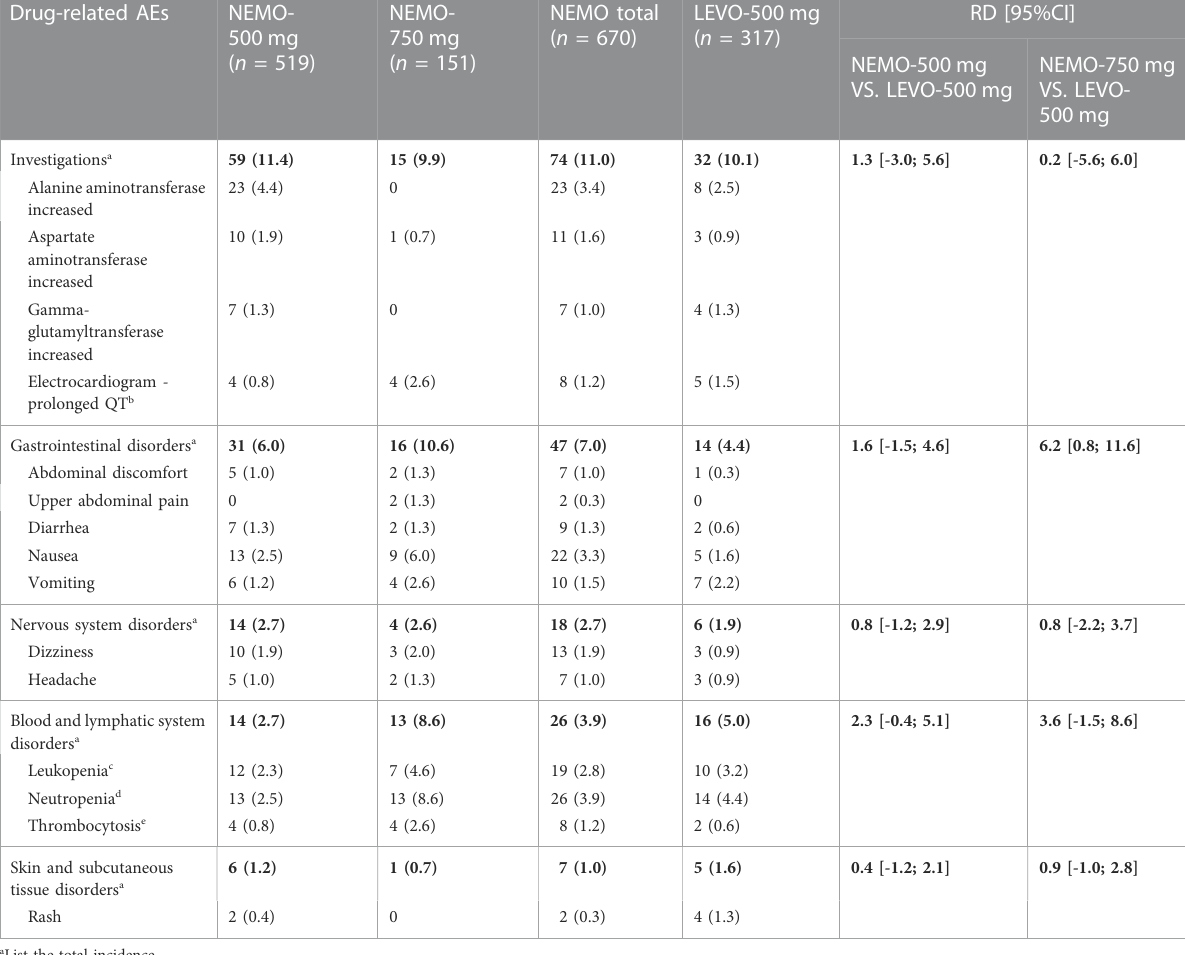
TABLE 3 Drug-related adverse effects with an incidence of ≥ 1% in Phase II/III clinical studies. Drug-related